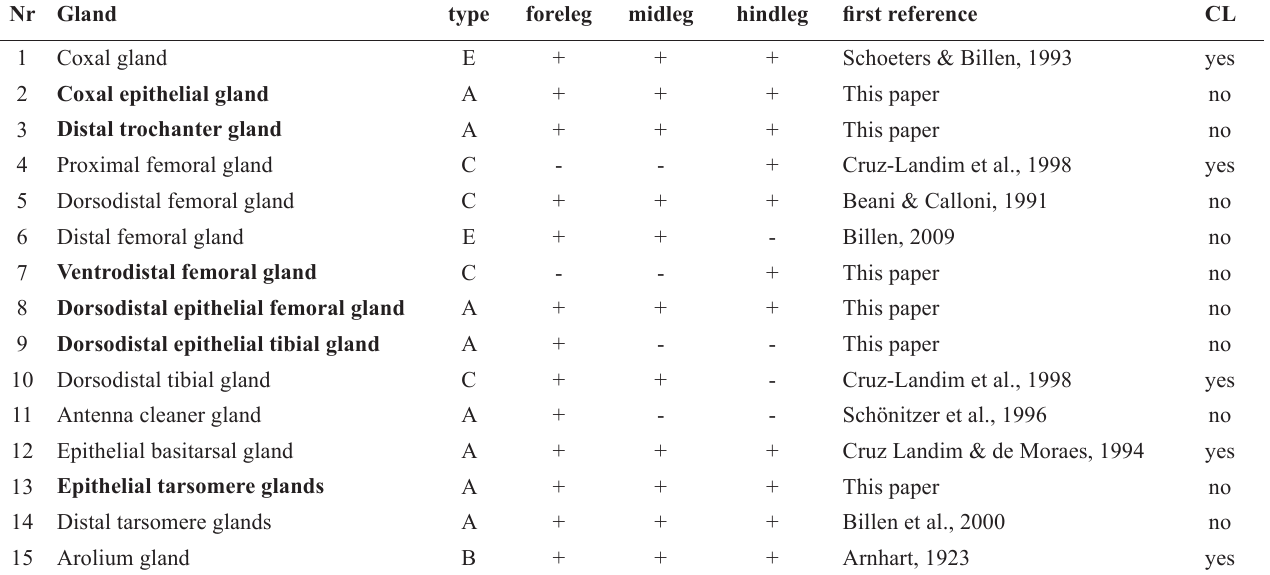
Table 1 . Survey of the various leg glands in workers of Frieseomelitta varia , and their occurrence in the three leg pairs. Gland names shown in bold represent exocrine structures that have not been reported before for social insects. Gland numbering is the same as in Figure 2 and in the main text, gland type corresponds with Figure 1. + indicates gland presence, - indicates absence. The right column ‘CL’ indicates whether or not the occurrence of a gland was reported in the 1998 review article on leg glands in Meliponini bees by Cruz-Landim et al. and the same author’s book chapter update in